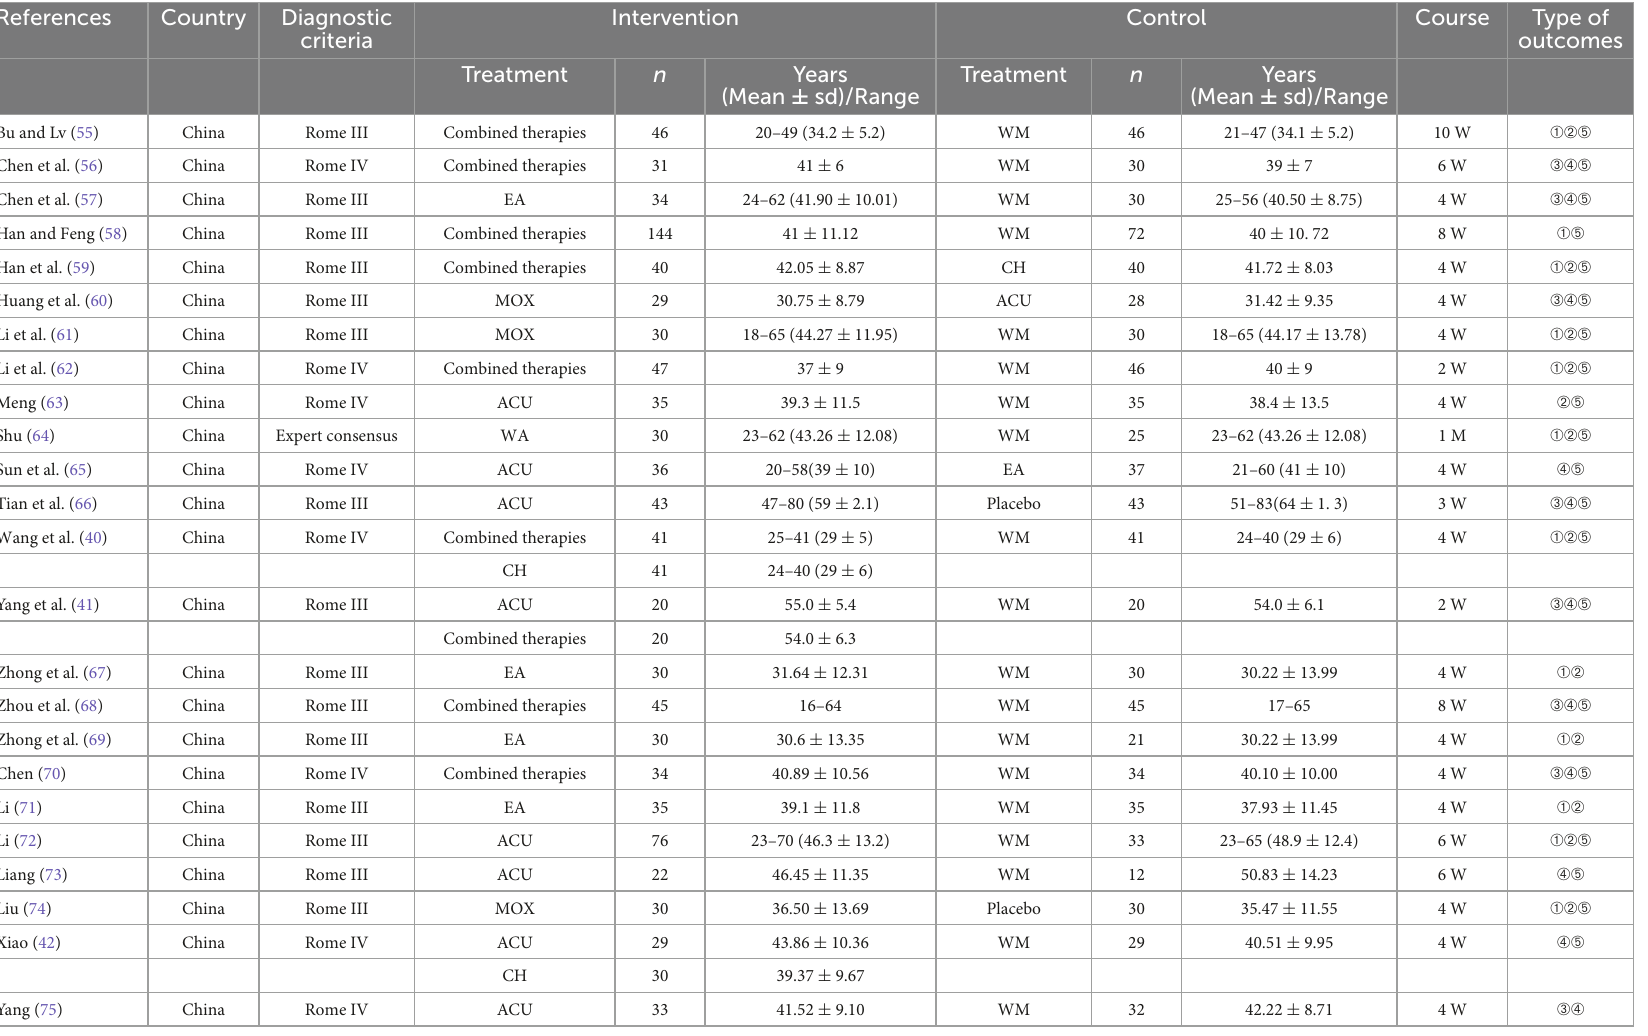
TABLE 1 Baseline characteristics of the included